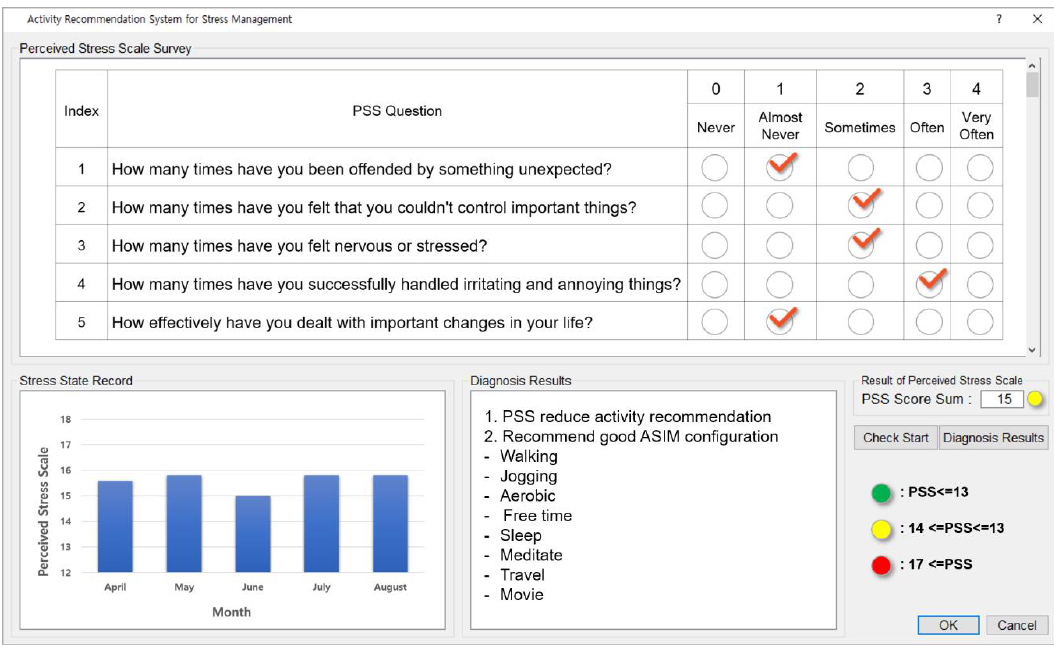
Figure 6. Activity recommendation system for stress management.